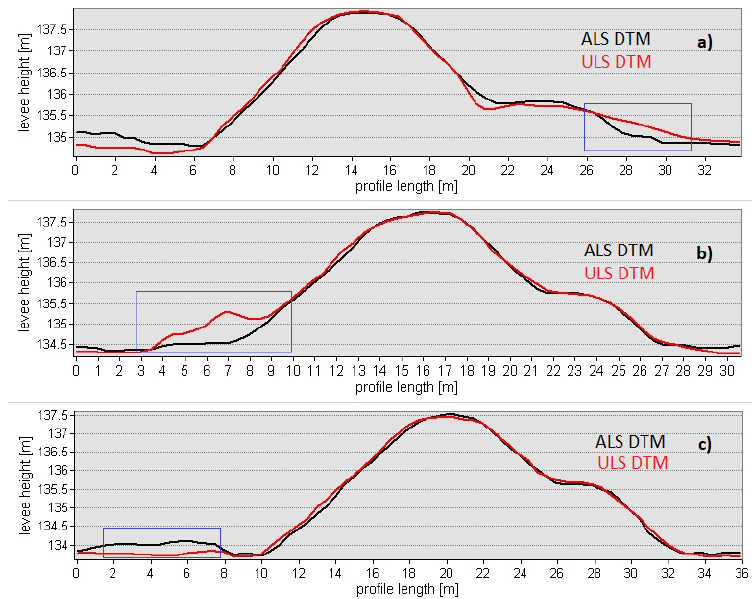
Figure 10. Profiles presenting the three examples of the differences between DTMs detected on the differential DTM and new unvegetation ground class with an indication of potential danger related to landslide of levee shaft ( a ), landslide of levee side ( b ) and random elevation changes (c) presented in two dimensions in Figure 9.